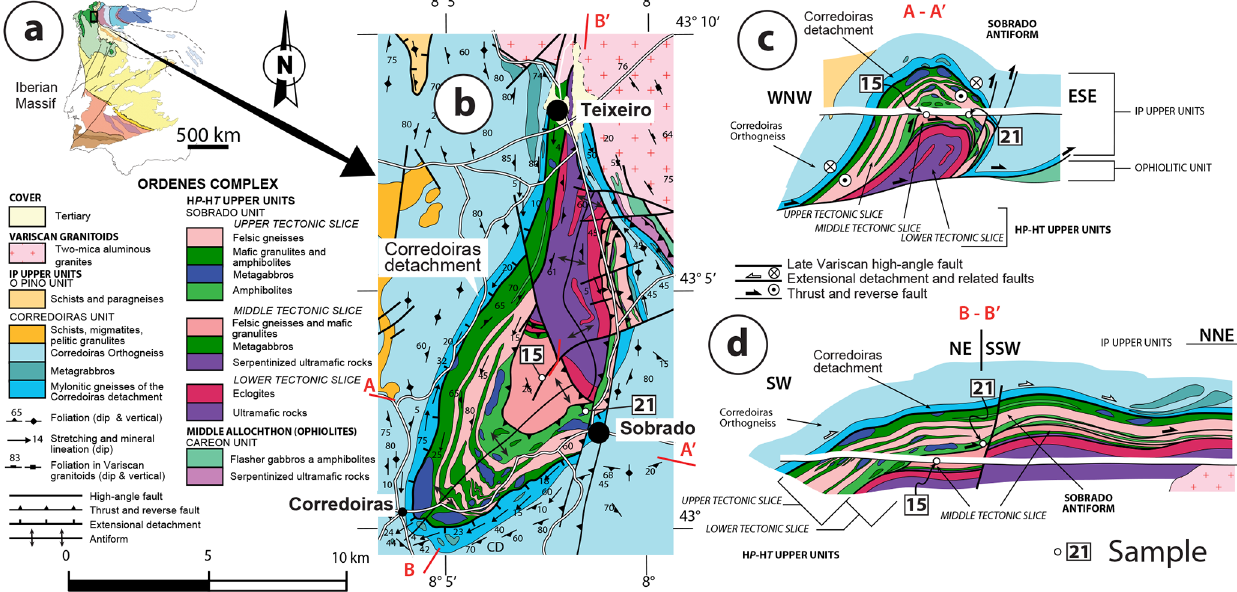
Figure 2. Geological map of the study area and location of the samples, modified from Arenas and Martínez Catalán (2002): (a) location of the Órdenes Complex within the Iberian massif. (b) Sobrado unit map, indicating units and tectonic slices. (c) Cross-section in the WNW– ESE direction and (d) SW–NE and SSW–NNE directions of the Sobrado antiform. Sample locations are indicated.